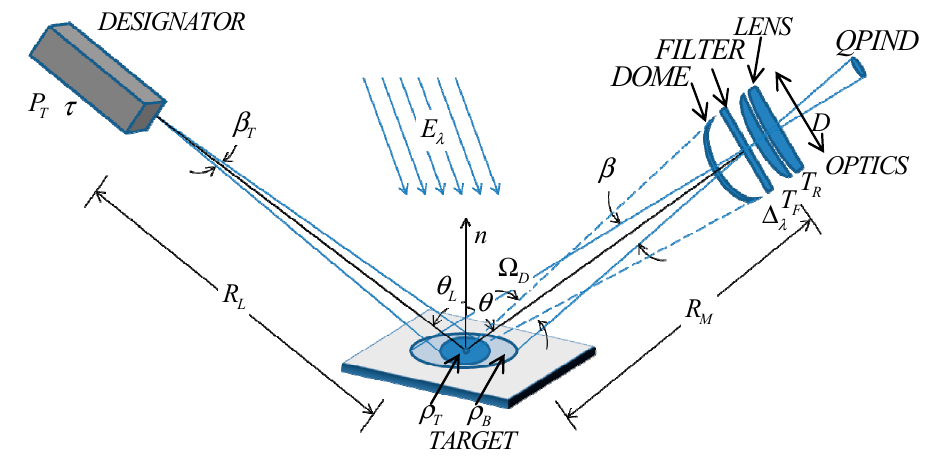
Figure 2. Modeling of semi-active laser guidance system.